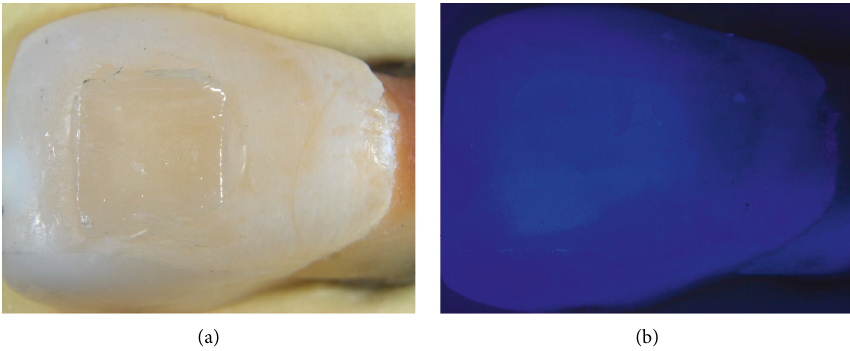
Figure 1: Adhesive remnant area analysis. (a) Adhesive after debonding; (b) fluorescent adhesive remnant under UV